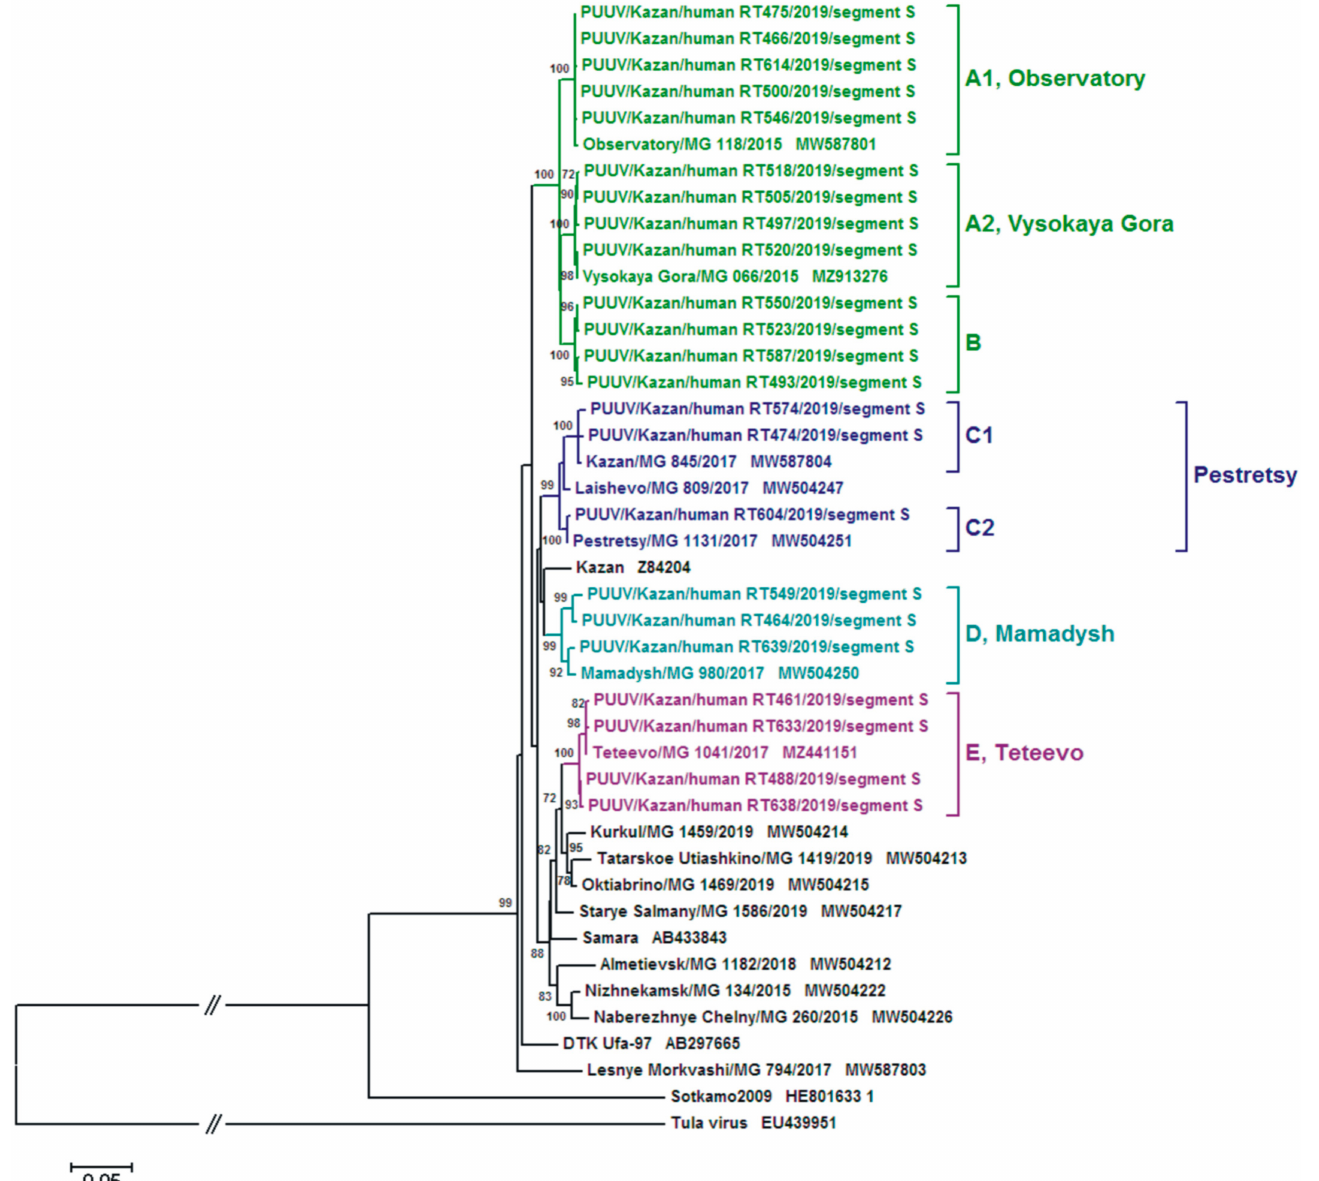
Figure 3. The phylogenetic tree based on the S segment CDS nt of Puumala orthohantavirus strains from hemorrhagic fever with renal syndrome patients and bank voles. The percentage of trees in which the associated taxa clustered together is shown next to the branches. For clarity, only taxa percentages above 70 are shown on the tree. Initial tree(s) for the heuristic search were obtained by applying the Neighbor-Joining method to a matrix of pairwise distances estimated using the Maximum Composite Likelihood (MCL) approach with 1000 bootstrap replicates. A discrete Gamma distribution was used to model evolutionary rate differences among sites (five categories (+ G , parameter = 0.5786)). The rate variation model allowed for some sites to be evolutionarily invariable ([+ I ], 49.8447% sites). The tree is drawn to scale, with branch lengths measured in the number of substitutions per